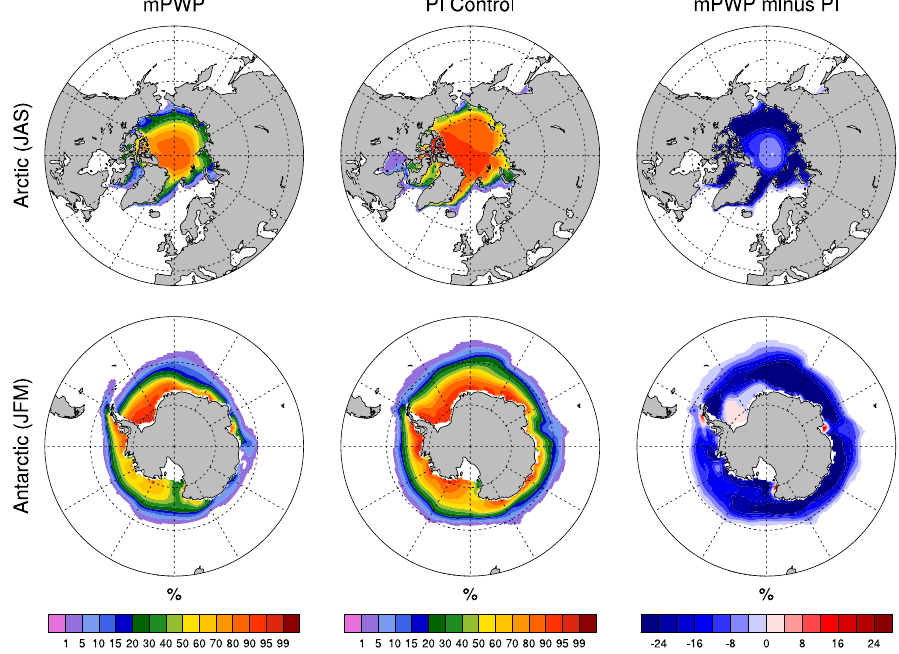
Fig. 8. Spatial maps of CCSM4 simulated Northern Hemisphere (July-August-September; JAS) (top) and Southern Hemisphere (January- February-March; JFM) (bottom) mean sea ice area (%) for the mPWP, the 1850 PI control, and their difference (mPWP minus